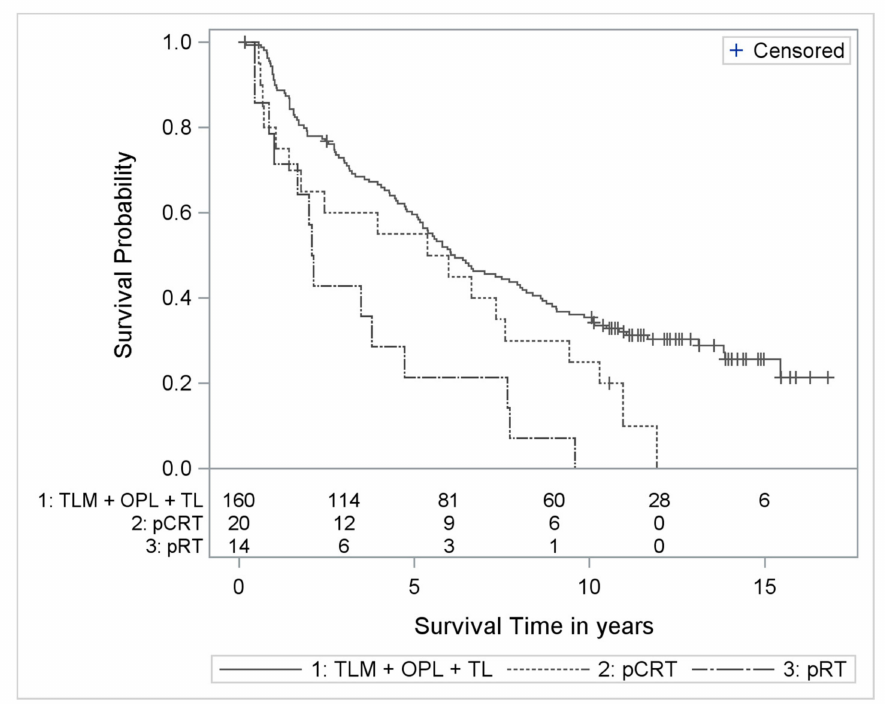
Figure 2. Kaplan Meier curves with numbers at risk of supraglottic cancers treated with pCRT or pRT compared to TLM + OPL + TL